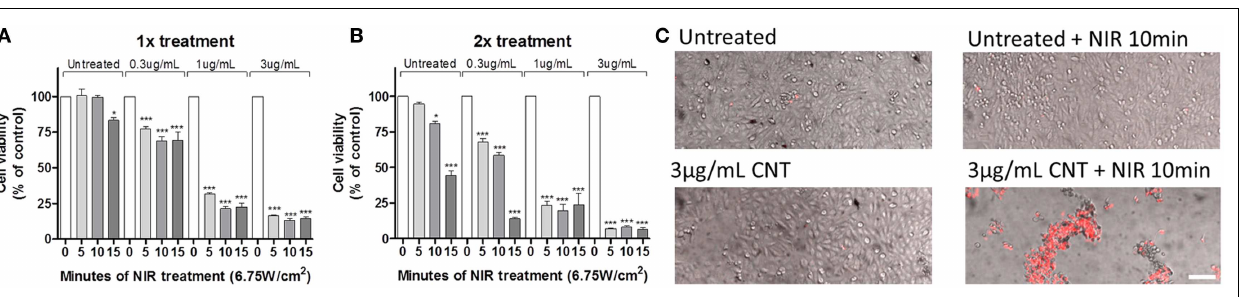
cell survival ( n = 3, * p < 0.05, *** p < 0.001 relative to 0min of NIR of each condition). (C) U251 glioma cells treated with CNTs (3 µ g/mL) and NIR (10min at 6.75W/cm 2 ) for 72h exhibit necrotic cell death as shown by propidium iodide uptake (PI, red). Scale bar is 50 µ m.